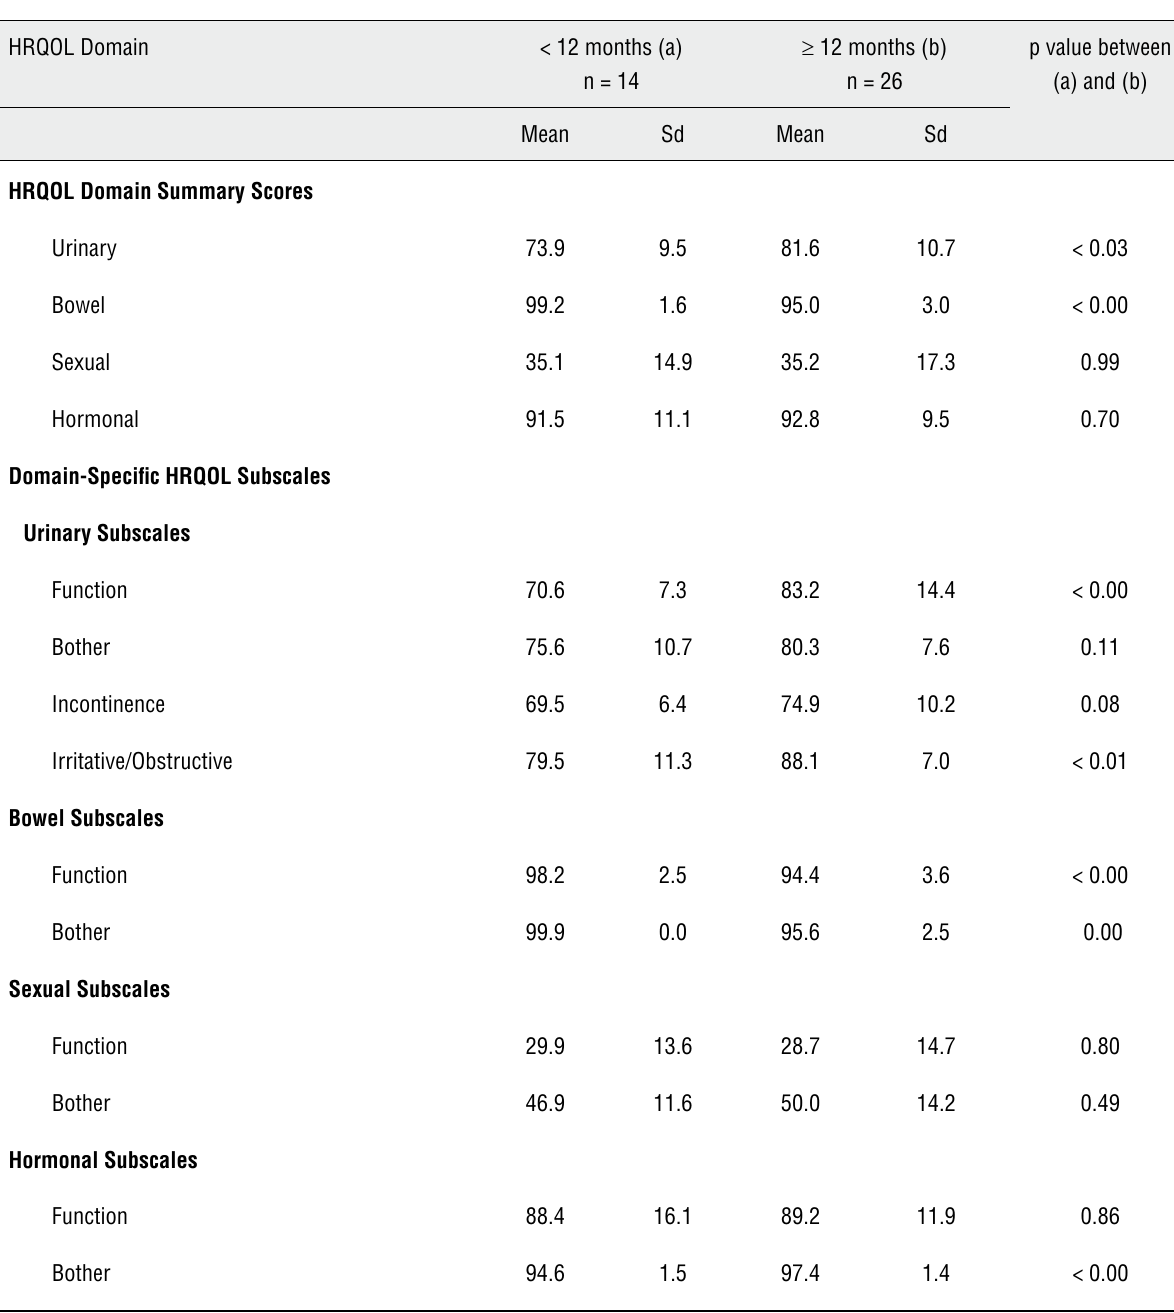
Tabela 5 - Correlation between the score and the EPIC segment postoperatively. HRQOL